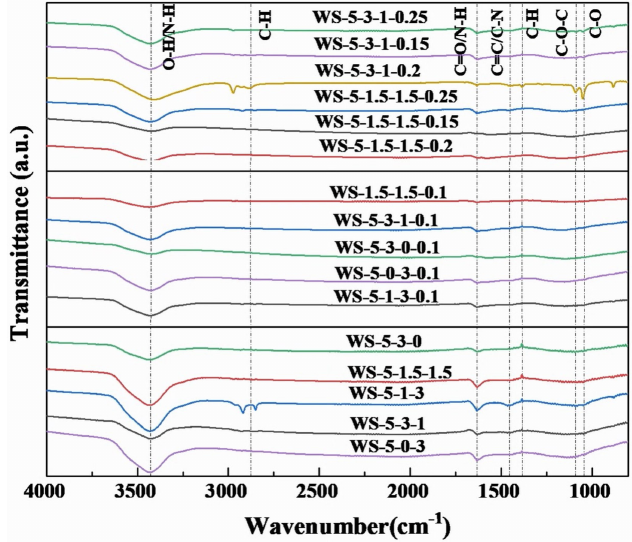
Figure 5. FT − IR spectra of